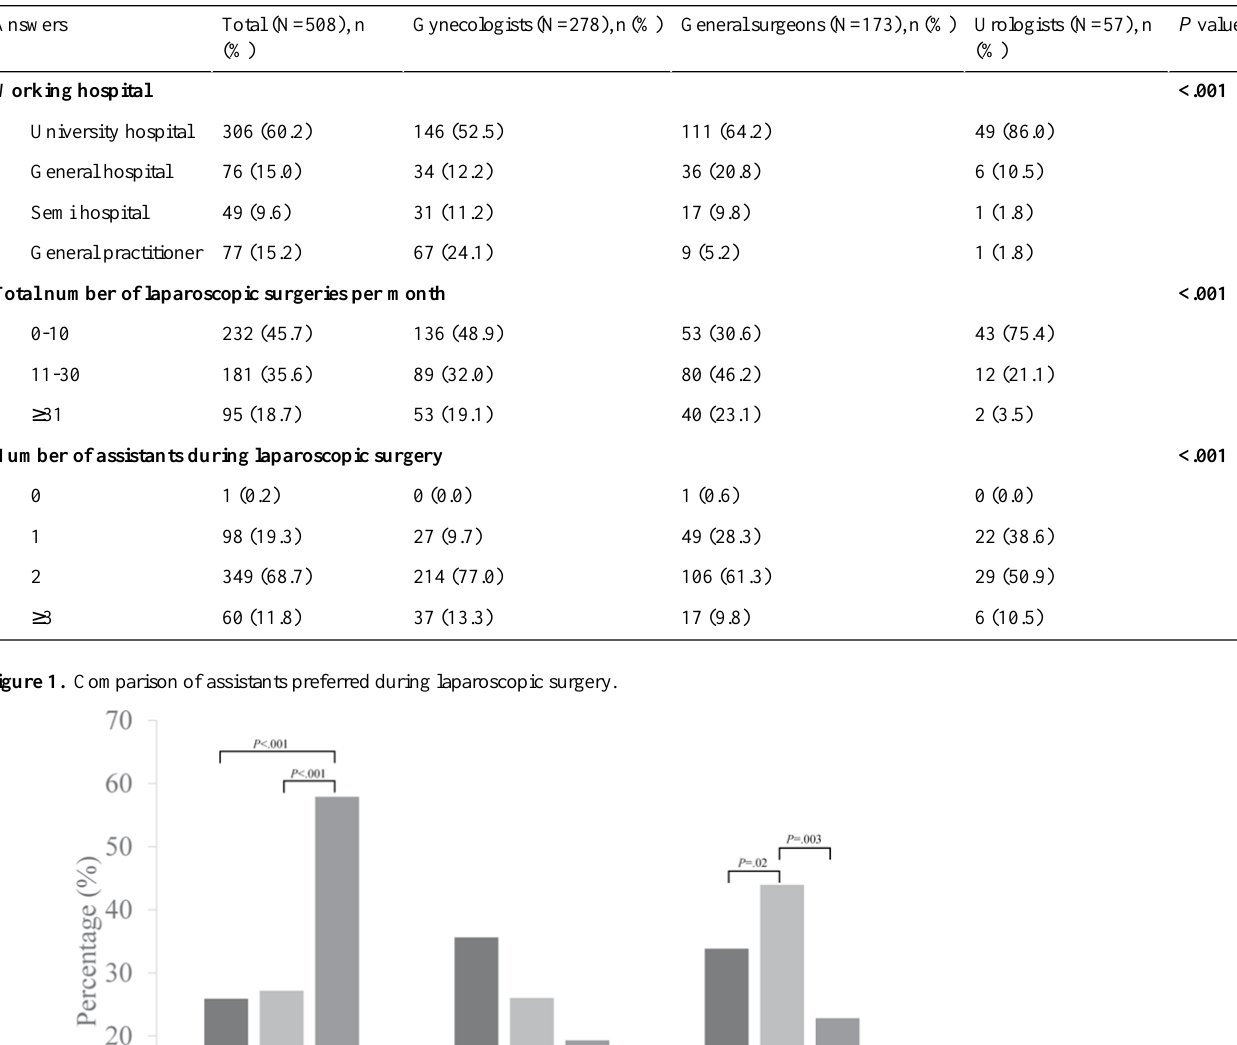
Table 2. Demographic data.